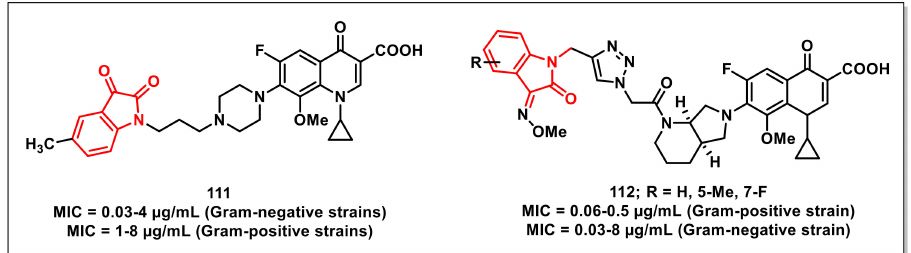
Figure 18. Ciprofloxacin and moxifloxacin-based isatin scaffolds as